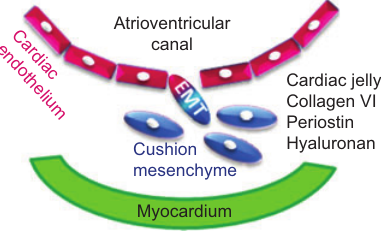
Figure 3 Formation of the cushion mesenchyme in the developing heart from the AV canal. The cardiac endothelial cells that overlie the cardiac jelly undergo an EMT giving rise to the cushion mesenchymal cells. These cells dis- perse within the cushions and undergo terminal differentiation into valvular fi broblasts, which are the precursor of the cardiac